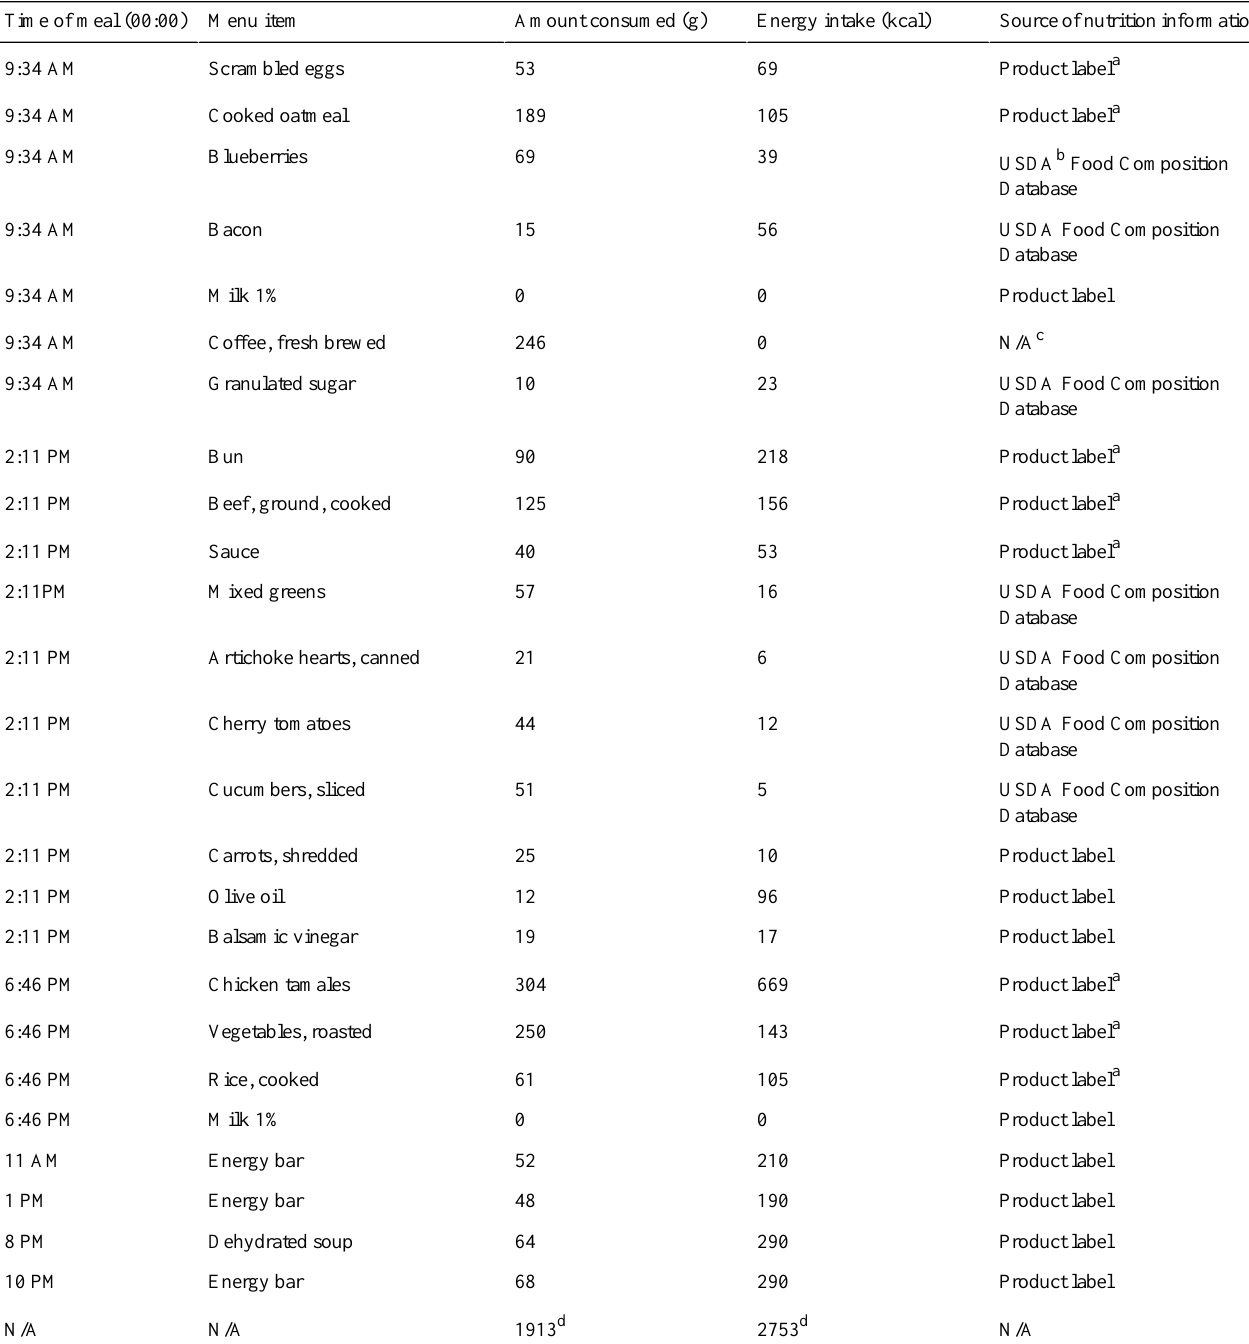
Table 1. Daily food intake record of 1 study